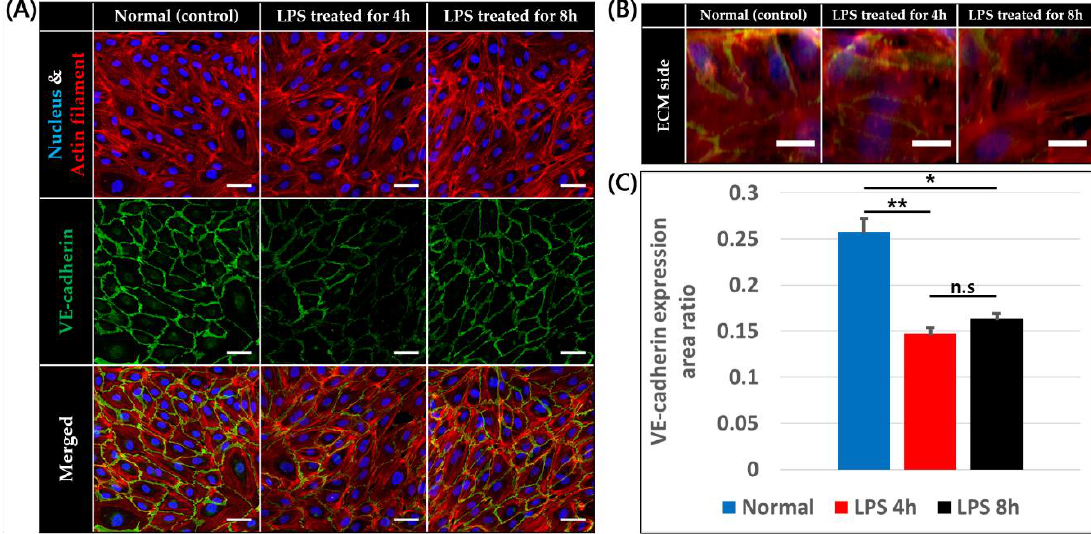
Figure 4. VE-cadherin expression of endothelial cells at 0, 4, and 8 h after LPS treatment. ( A ) Confocal image of endothelial cells on basal plane stained for nucleus (blue), actin filament (red), and VE-cadherin (green), scale bar = 50 μm. ( B ) Z-stack image of endothelial cells on ECM side stained for nucleus (blue), actin filament (red), and VE-cadherin (green), scale bar = 20 μm. ( C ) VE-cadherin expression area to endothelial cell area ratio on basal plane (n = 4 × 3 for normal and LPS treated for 4 h, n = 3 × 3 for LPS treated for 8 h, n.s: not significant *: p < 0.0001, **: p < 0.00001).